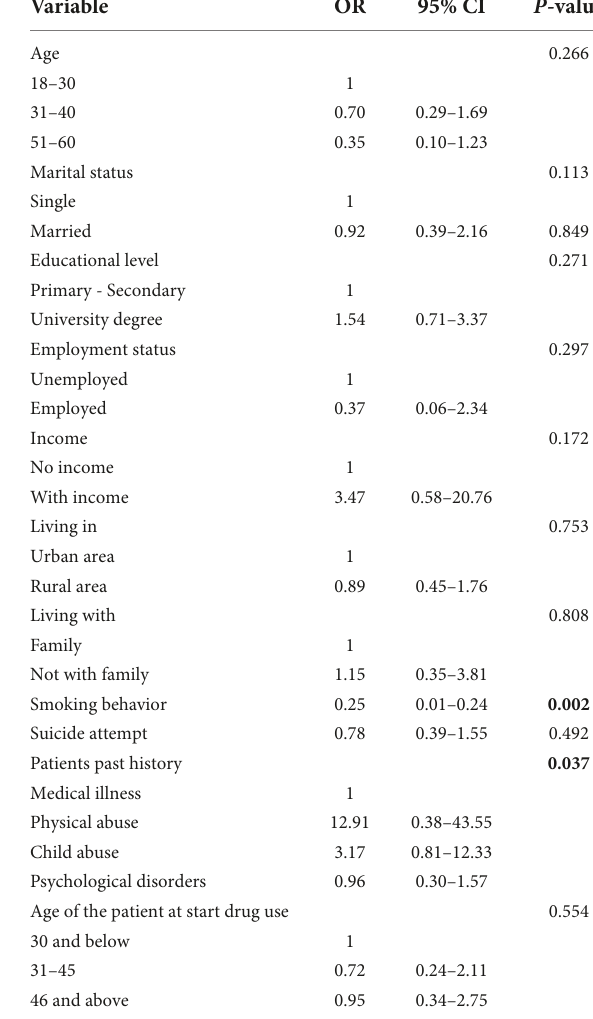
TABLE 5 Association between demographic factors and substance use of the participants using the logistic regression